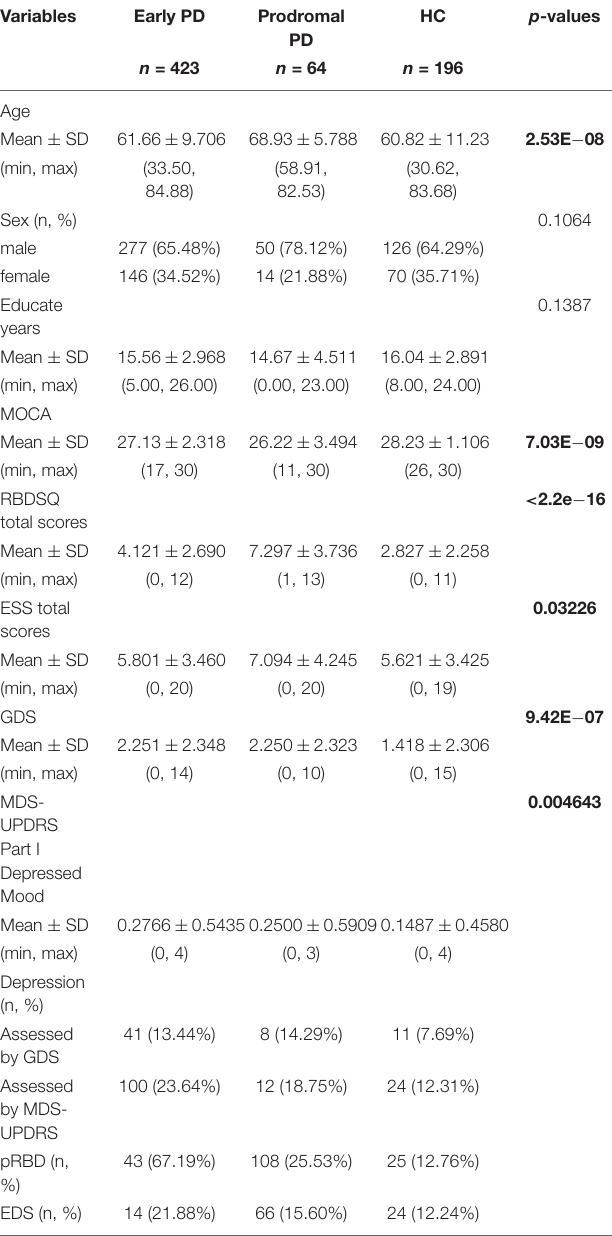
TABLE 1 | Baseline characteristics of participants of three